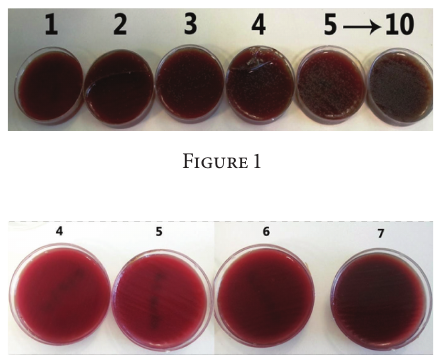
Figure 2: Growth of Streptococcus sanguis on plates